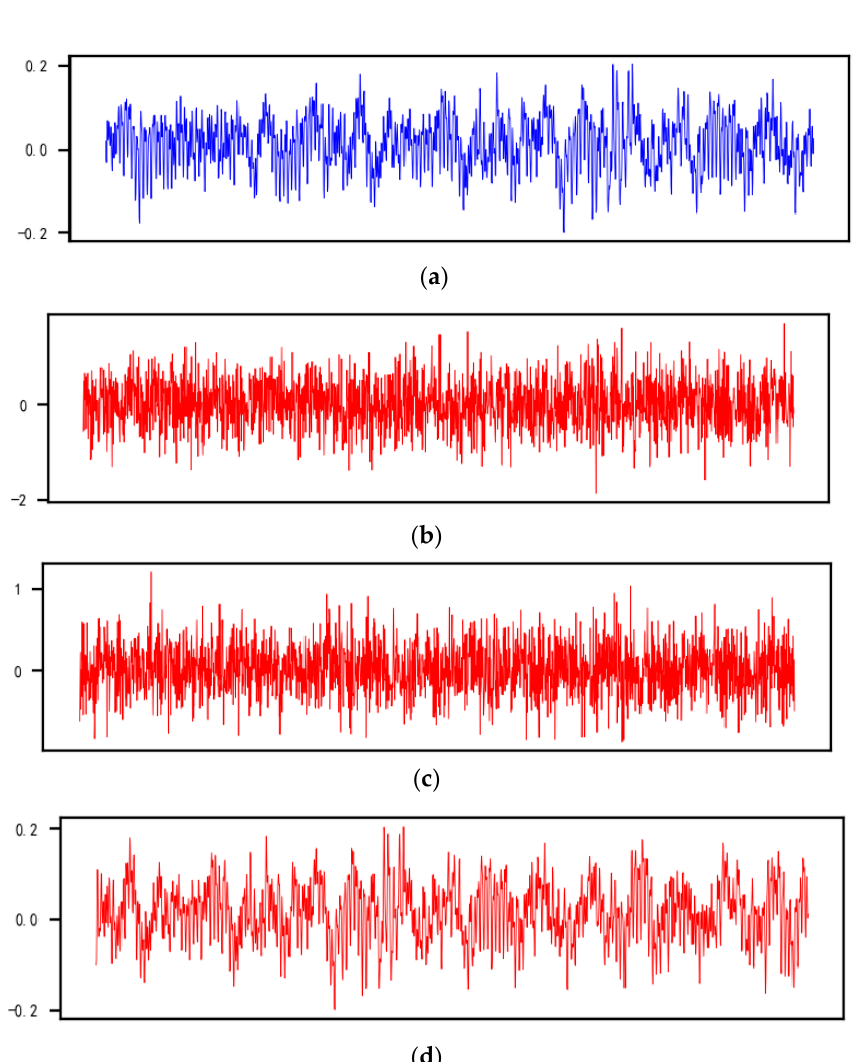
Figure 12. Comparison of different data generation methods-generated samples. ( a ) Actuator inner leakage real sample. ( b ) GAN generated sample. ( c ) Conditional-GAN generated sample. ( d ) ACWGAN-gp generated sample.